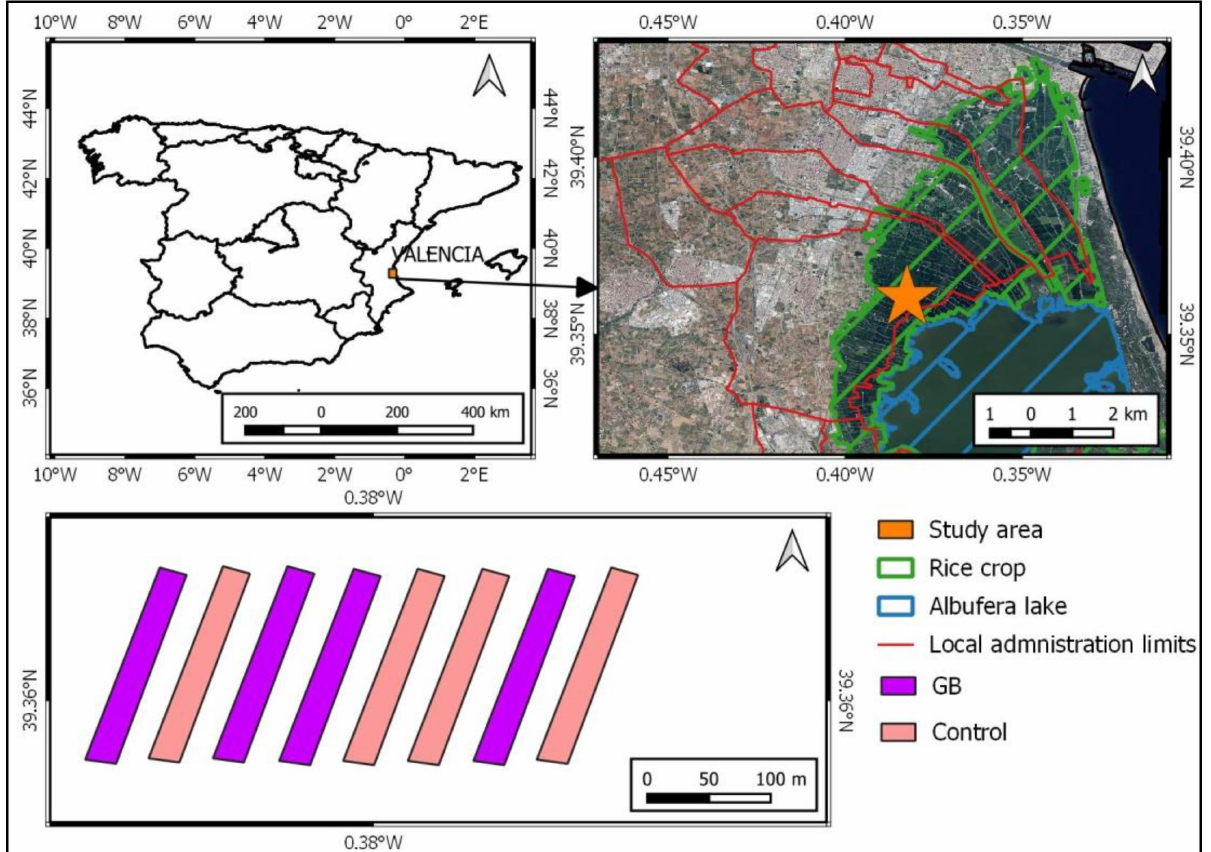
Figure 1. Location of the experiment in the study area. Arrow indicate the proper position. Phenological stages were classified according to the BBCH scale [56]. Figure 2 shows the phenological cycle of the crop in the experimental plot and the periods when the fields are dried. Climatic data were registered by a datalogger [57]. Figure 3 shows the most important meteorological crop growth parameters that were retrieved: air temperature (T) and relative humidity (RH) (no rainfall occurred during the drying periods).